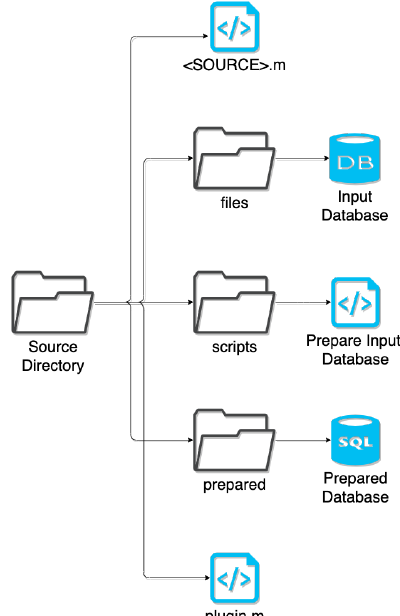
Figure 10. Structure of each source’s sub-directory. <SOURCE>.m refers to the MATLAB script